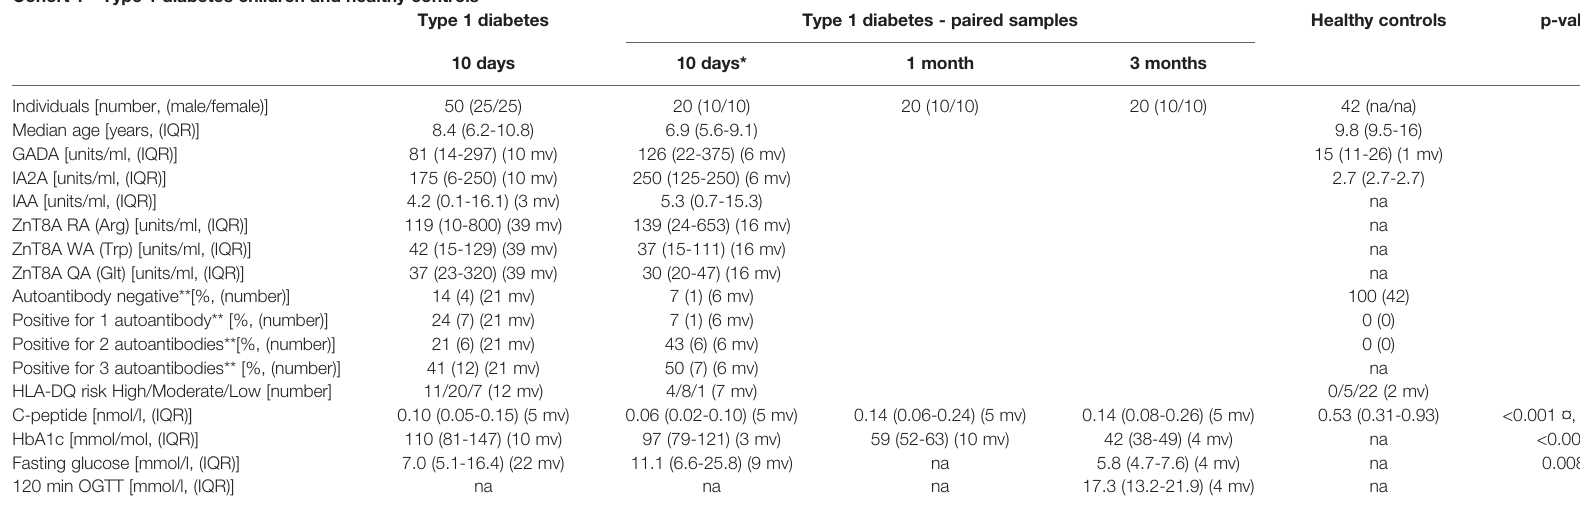
TABLE 1 | Characteristics of the three cohorts of children included in the study. Cohort 1 - Type 1 diabetes children and healthy controls